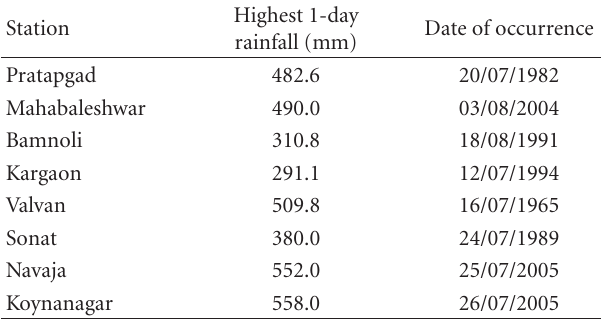
Table 1: Highest 1-day rainfall (mm) for stations in the Koyna